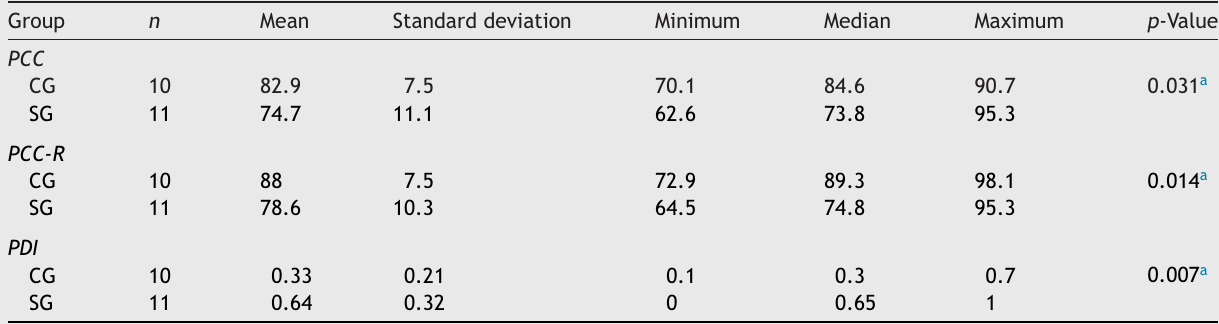
Descriptive statistics for Percentage of Consonants Correct (PCC), Percentage of Consonants Correct-Revised